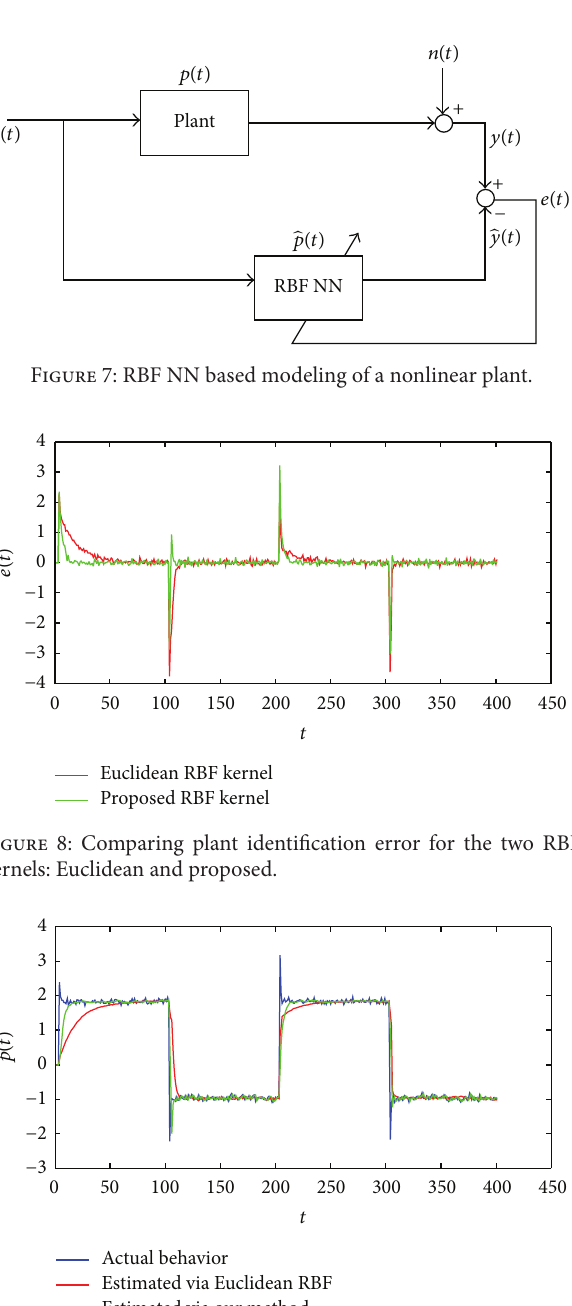
Figure 11: Transmitted symbols scatter plot for 𝑀 = 16